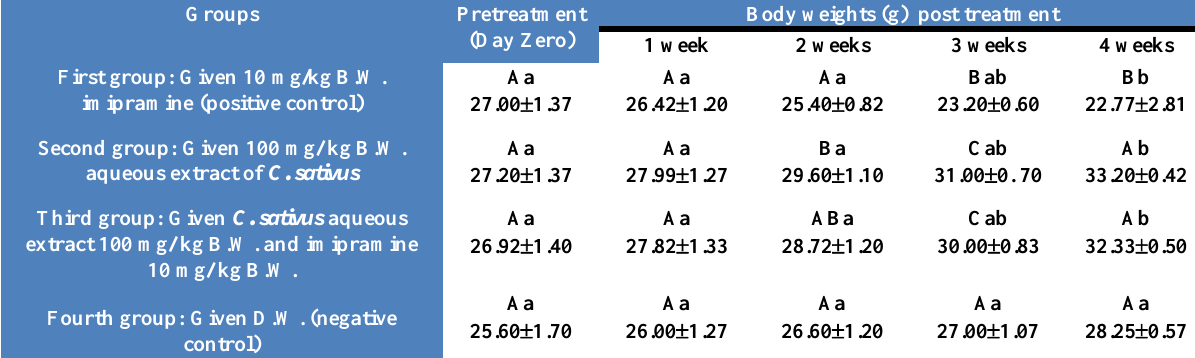
Luteinizing hormone Testosterone hormone (ng/ml) (ng/ml)